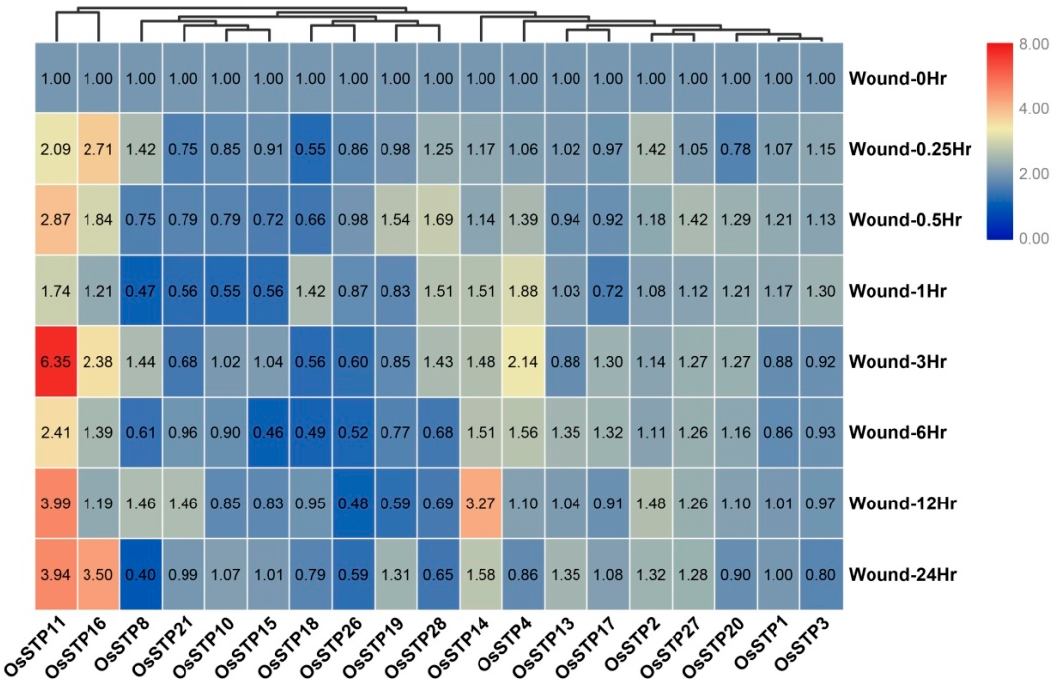
Figure 6. Expression changes of rice STP genes after blast infection. Blast mean rice blast infection and Hr represent hour after infection. The color scale represents fold changes (2 −ΔΔ CT method): the red color indicates high up-regulation and the green color represents low up-regulation.